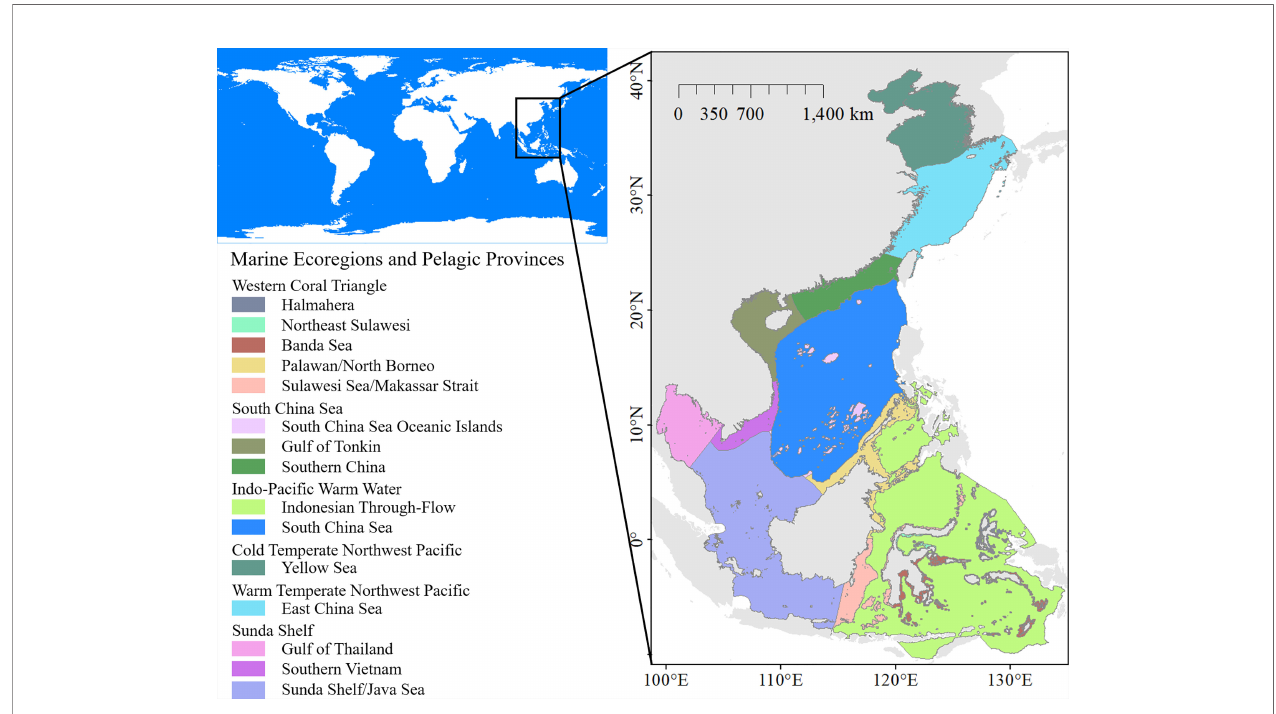
FIGURE 1 | The study region, marine ecoregions, and the pelagic